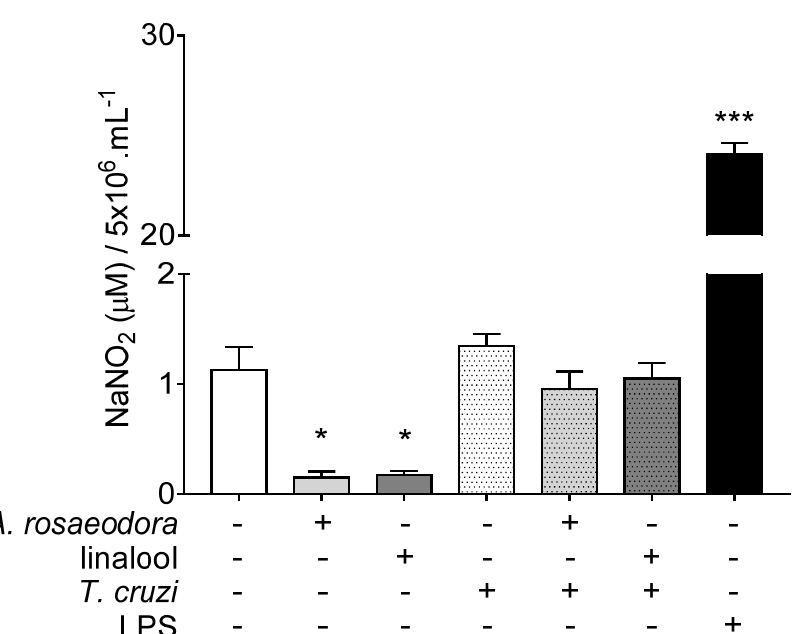
Figure 6. Nitrite quantification in the supernatant of the BALB/c peritoneal macrophage treated with Aniba rosaeodora essential oil (500 µg/mL) or linalool (125 µg /mL), and stimulated or not with Trypanosoma cruzi . Data represents mean ± standard deviation of experiment realized in sextuplicate; * p < 0.05, *** p < 0.001 when compared with untreated and unstimulated macrophages by Kruskal–Wallis and Dunn’s multiple comparison test.